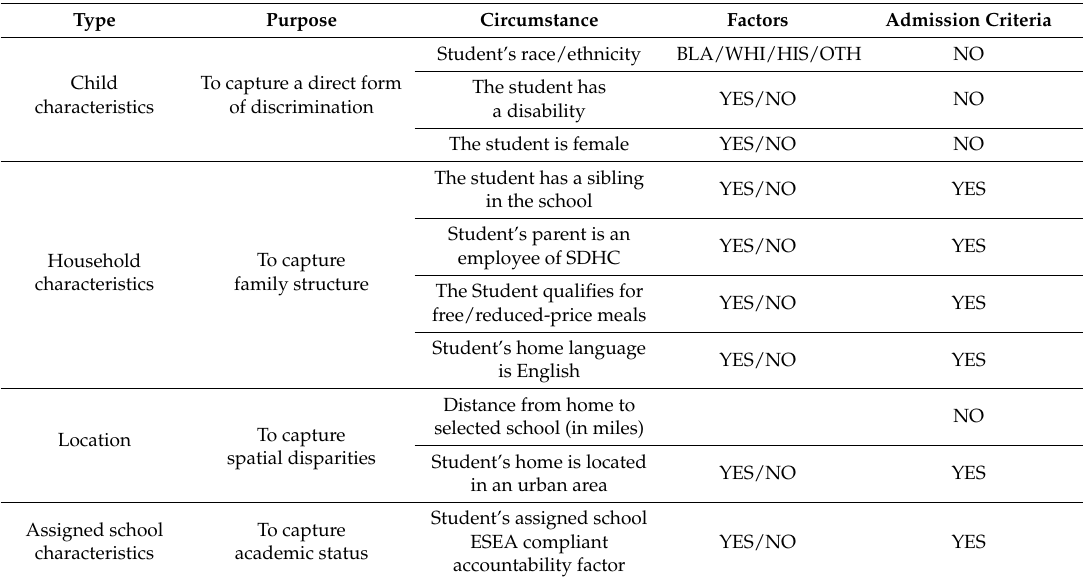
Table 3. Choice of circumstances for access to high-quality